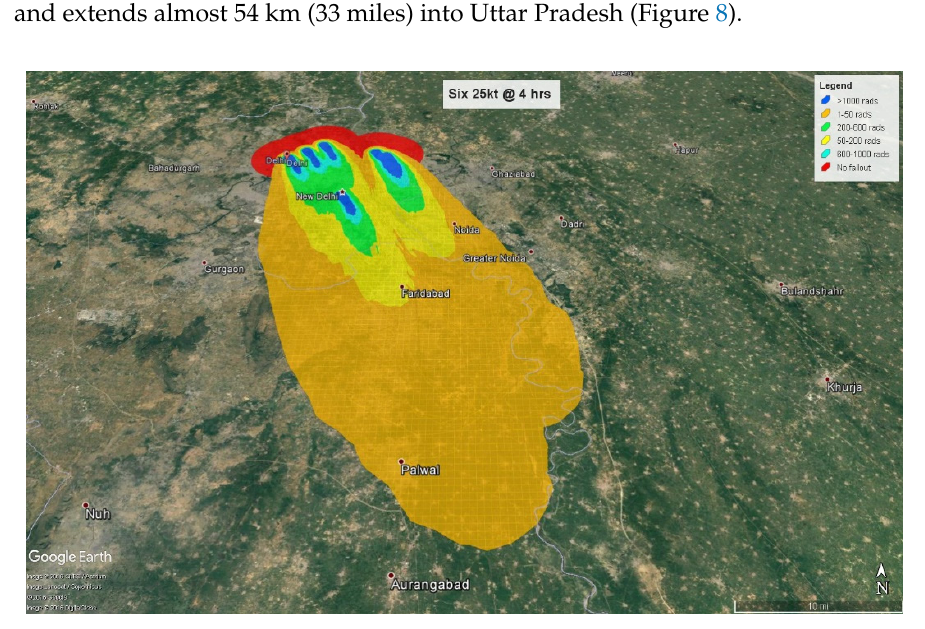
Table 5. Human casualties from fallout radiation only (1 × 25 kt nuclear weapon).